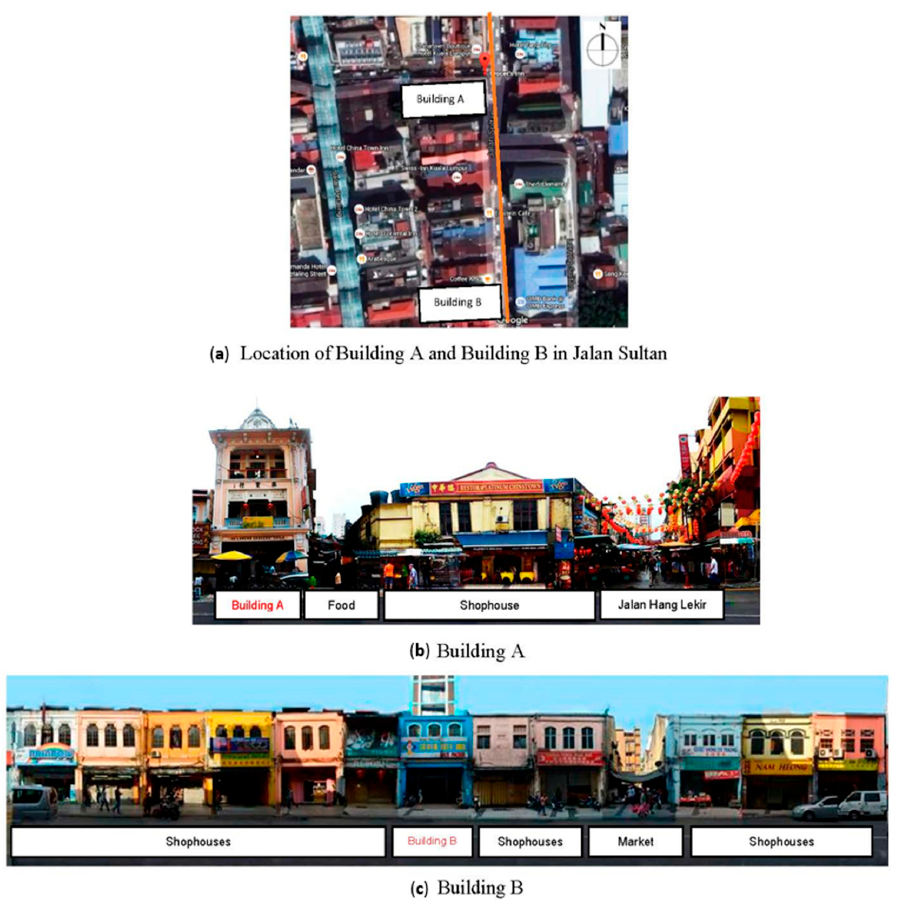
Figure 3. The relation of Building A and Building B with context (Google map, 2017).